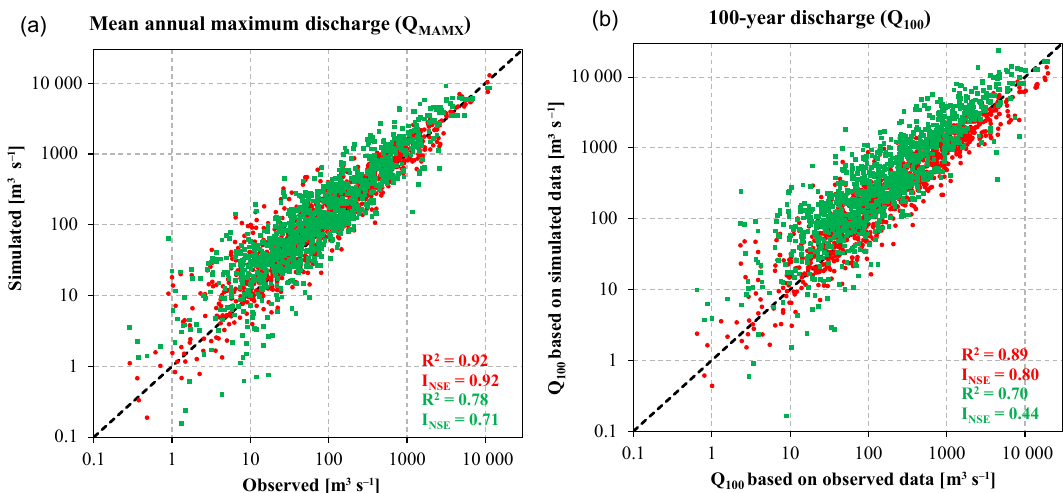
Figure 9. Simulated and observed average annual maxima of daily river discharges and 100-year discharge for 476 stations; Bayesian network model in red, regional frequency analysis in green. 30-year periods of annual maxima were used (the most recent available out of